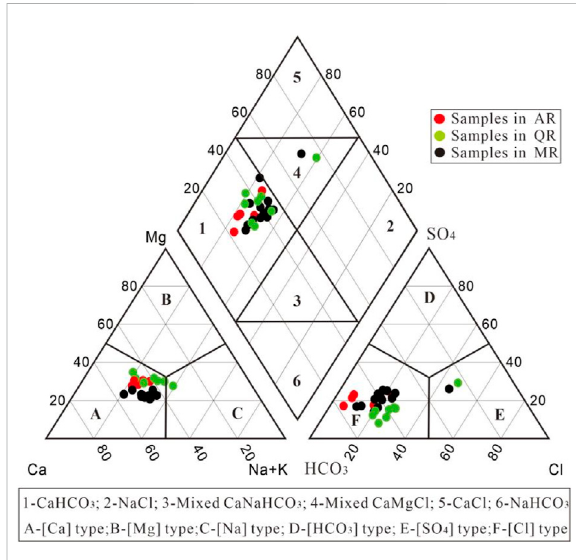
FIGURE 3 Piper ternary diagram of the surface water samples in the